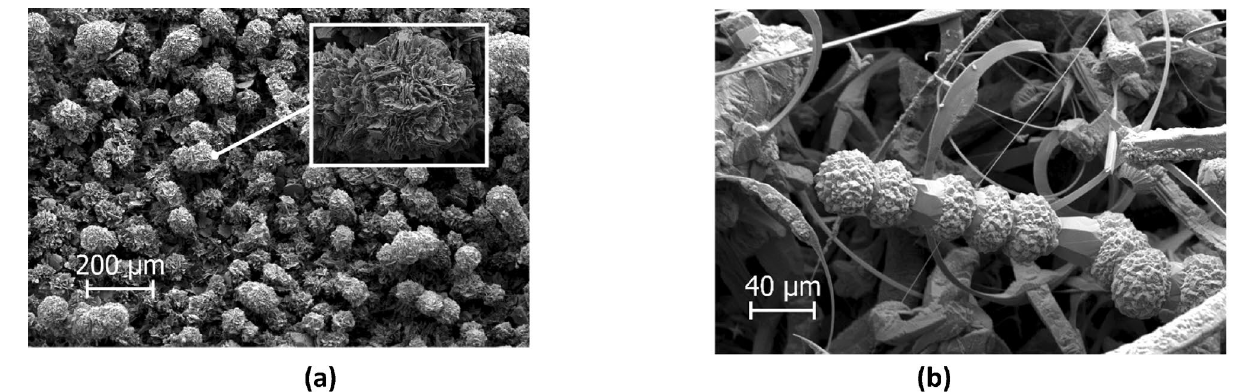
Figure 14. The SiC structures formed in the dark bottom region of the crucible at 1650 °C using 5% CH 4 in H 2 as the process gas, (a) is from the top of the dark region and (b) is a bit further